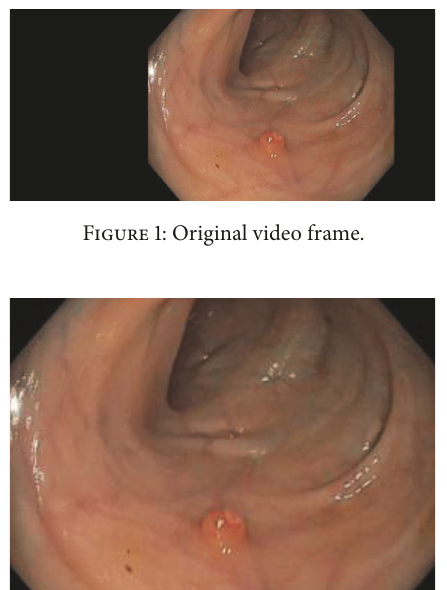
Every RGB image has three-color channels: red, green, and blue. So input image, 𝐼 (sliding window) is decomposed into three-color channels 𝐼 𝐶 , where 𝐶 = 𝑟, 𝑔, 𝑏.𝐷 6